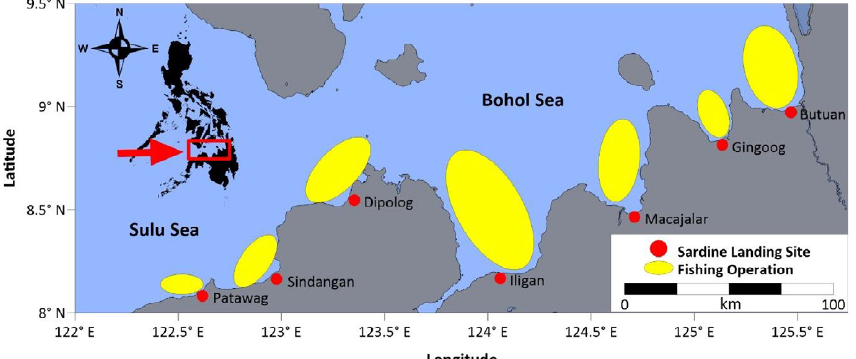
Table 1: Sampling frequency and number of sardines used in this study Period Bays